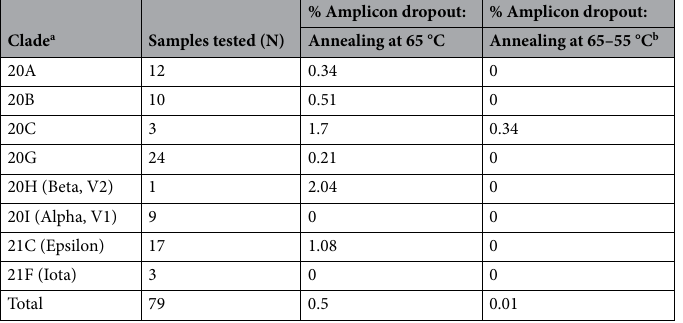
Table 1. Comparison of percent amplicon dropout by annealing temperature settings. a SARS-CoV-2 clades were assigned with Nextclade v1.3.0 (https:// clades. nexts train. org/). b Touchdown PCR gradually reduced the annealing temperature from 65 °C to 55 °C (0.7 °C/second) within each cycle.